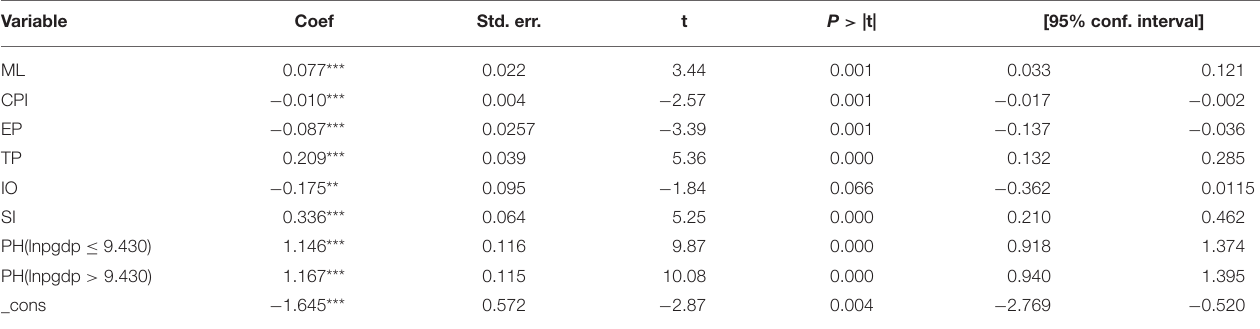
TABLE 4 | Estimated results of the economic growth threshold model.